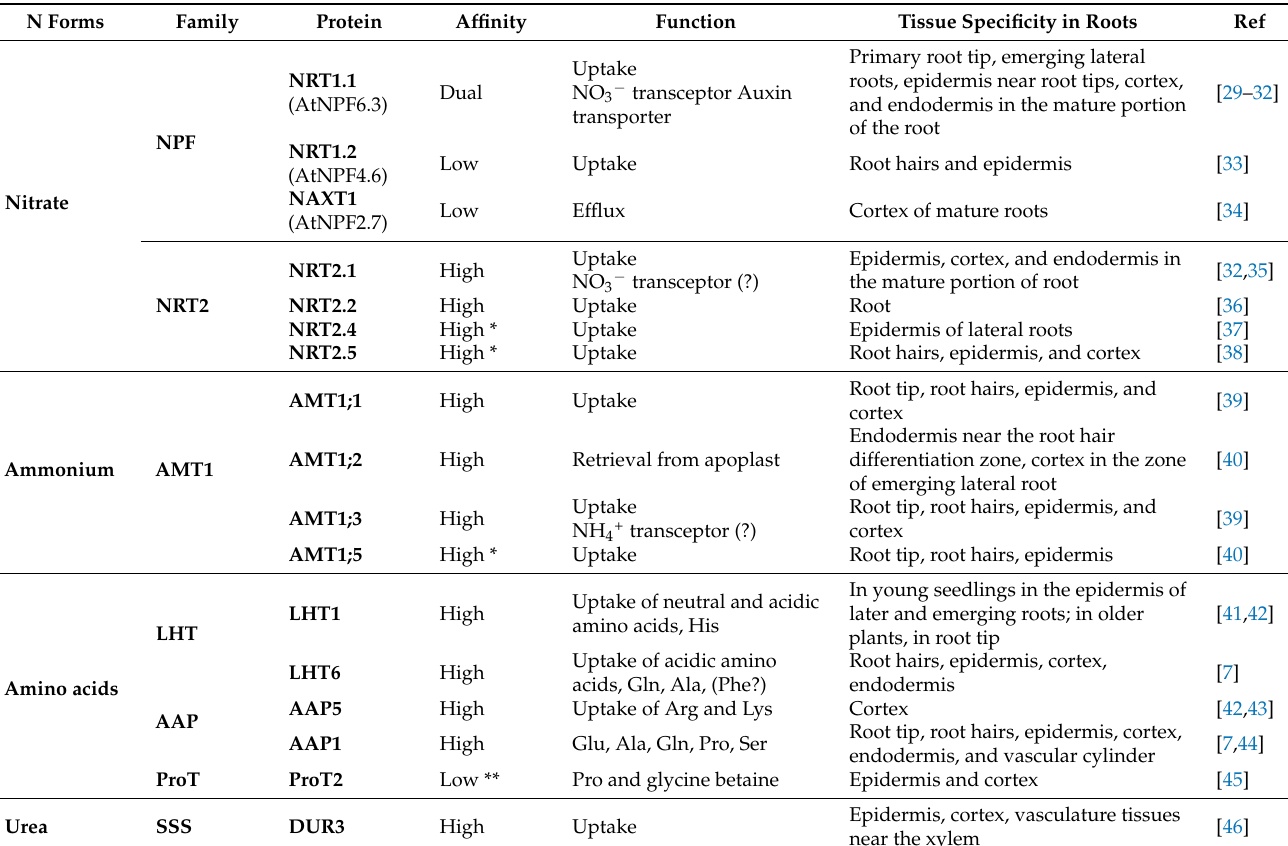
Table 1. Transporters involved in N uptake in roots of Arabidopsis thaliana . The table reports the main information about transporters, family, affinity range, and tissue specificity in